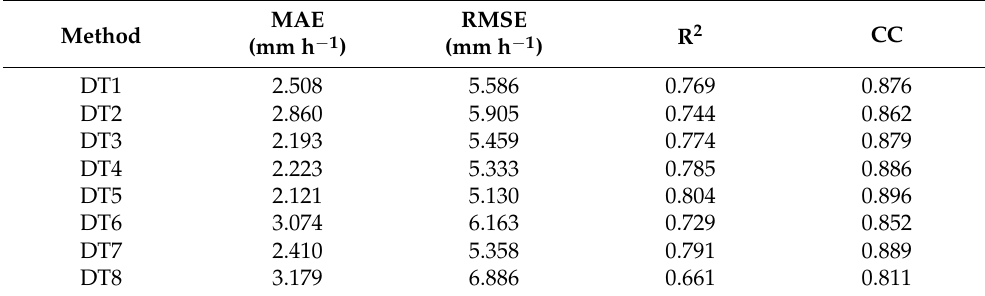
Table 6. Performance metrics of tree-based models (DT and RF) for estimation of Ks with eight different soil